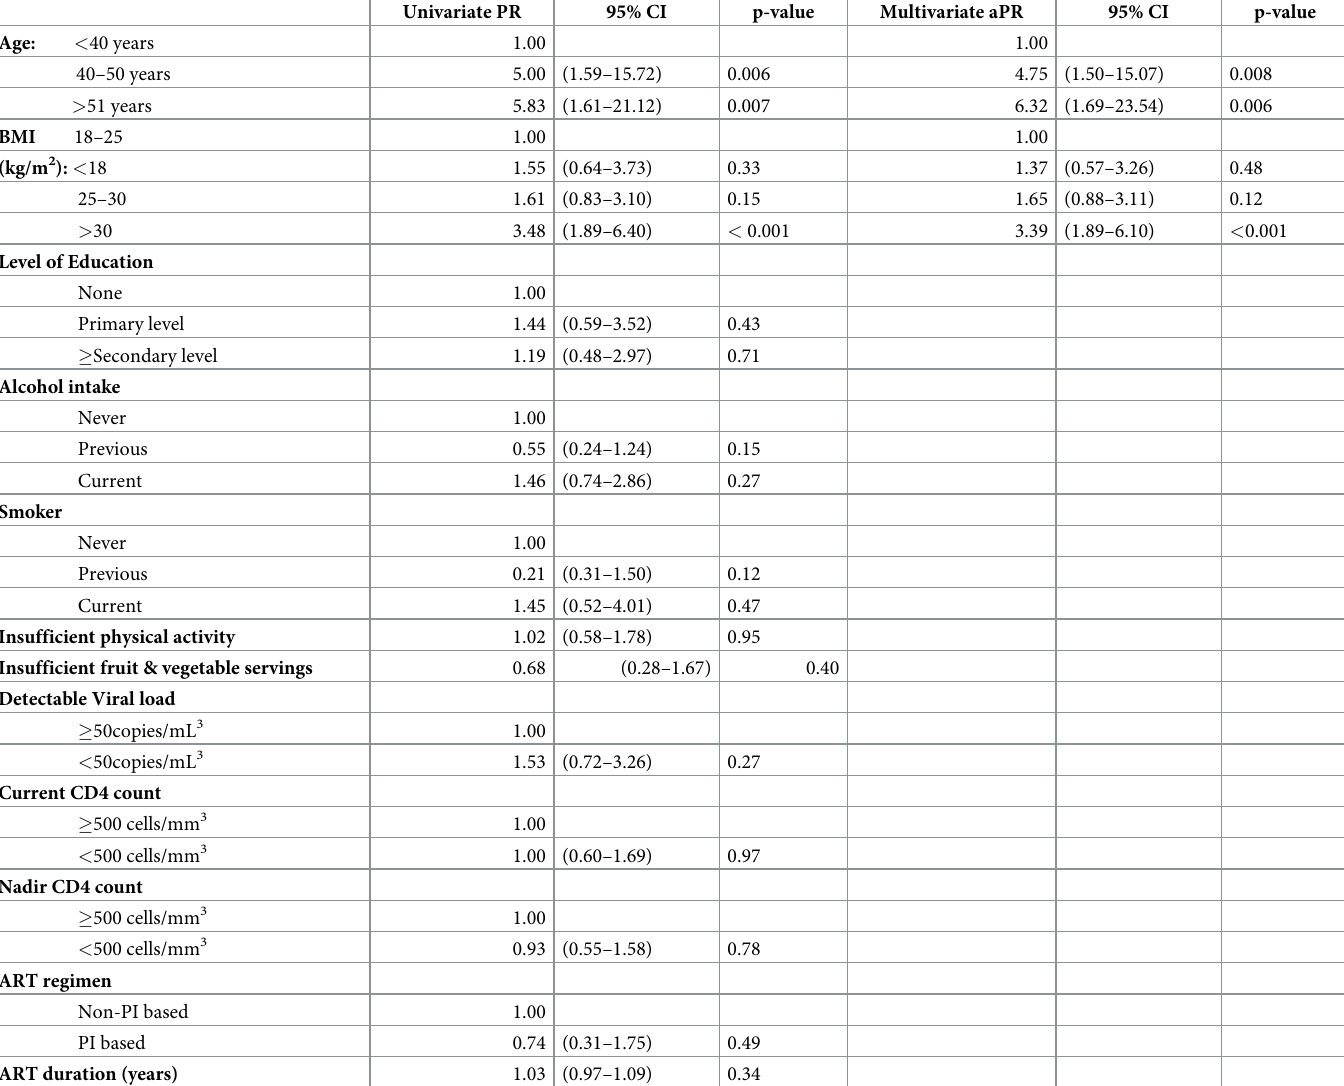
Table 4. Univariate and multivariate associations between risk factors and hypertension among PWH 1